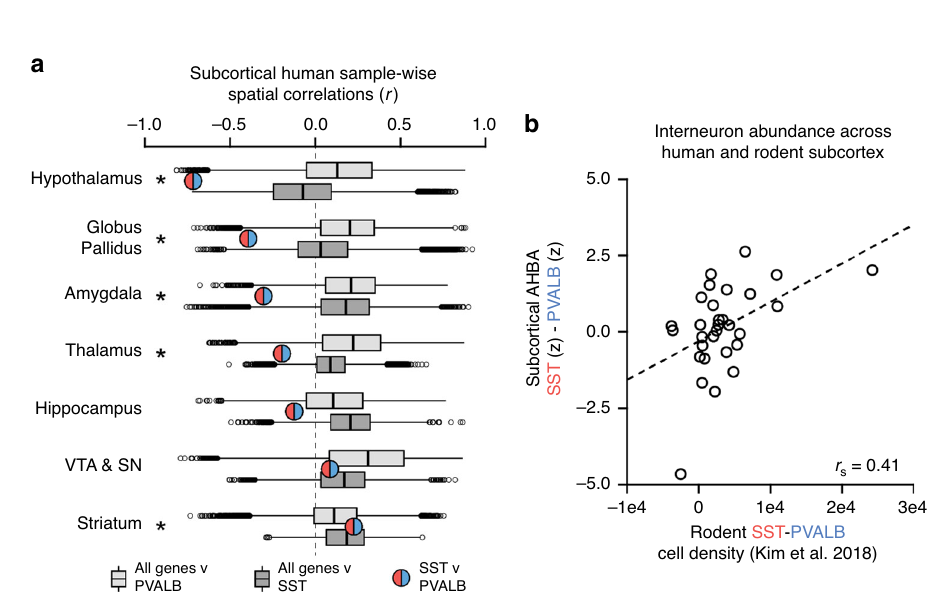
Fig. 3 Subcortical SST and PVALB correlation and consistency in rodents. a The correlation between SST and PVALB was estimated using AHBA data for each of seven subcortical territories. Red/blue circles denote Pearson correlations between SST and PVALB . Light and dark gray boxplots show the distribution of spatial correlations of all other genes ( n = 17,447) to PVALB and SST , respectively (center = median, box = Q1 – Q3, whiskers = 1.5*IQR, circles = outliers). The strength of the SST to PVALB relationship is quanti fi ed relative to gene-wide reference distributions. SST was more negatively correlated to PVALB than what is expected by chance in the hypothalamus ( r (100) = − 0.72, q = 1.9e − 16, AUC sst = 0.002, AUC pvalb = 0.01), globus pallidus ( r (37) = − 0.39, q = 0.011), amygdala ( r (65) = − 0.30, q = 0.019), and thalamus ( r (173) = − 0.19, q = 0.019), but not the hippocampus ( r (156) = − 0.12, q = 0.14), ventral tegmentum/substantia nigra ( r (63) = 0.09, q = 0.50), and striatum ( r (168) = 0.23, q = 0.011). b Relative expression of SST and PVALB in human subcortical areas when compared to ground truth cell densities in rodent homologs from Kim et al. 11 (Spearman ’ s r In particular, the central nucleus (CeA) of the amygdala was enriched for SST in both rodents (SST density = 24,342.60, PVALB density = 119.42) and humans (SST expr(z) = 1.27, PVAL- B expr(z) = − 0.76), paralleling observations in primates 34 . We also found greater relative SST in the ventral tegmental area (VTA) for both rodents (SST density = 1953.98, PVALB density = 426.10) and